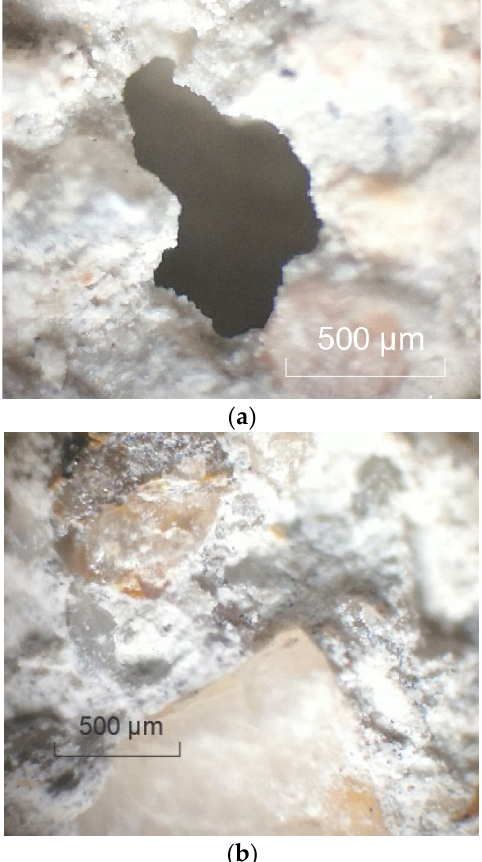
Figure 16. Images of the raw RCA obtained with optical microscope (magnification: 40). ( a ) Pore; ( b ) adhered mortar.